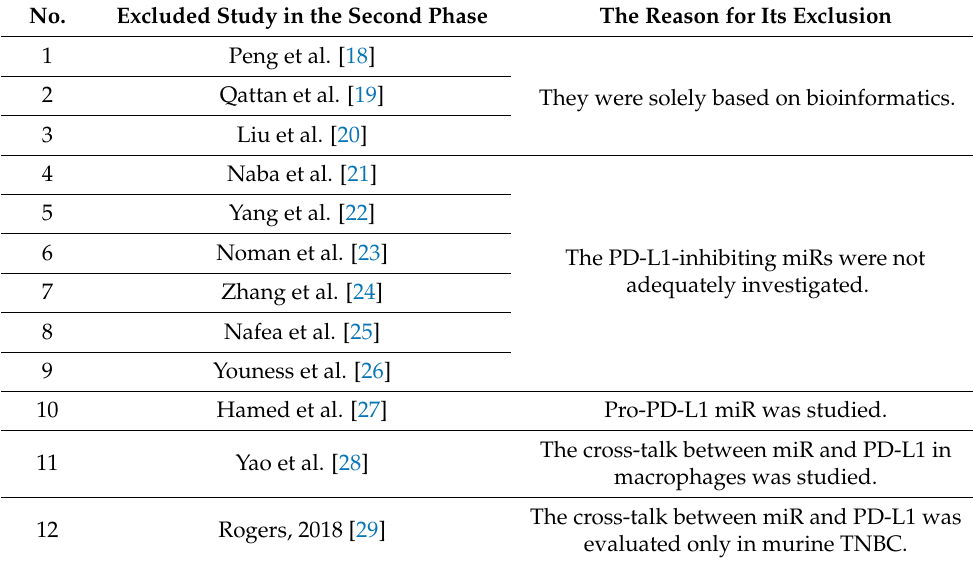
Table 1. The excluded studies and the reasons for their